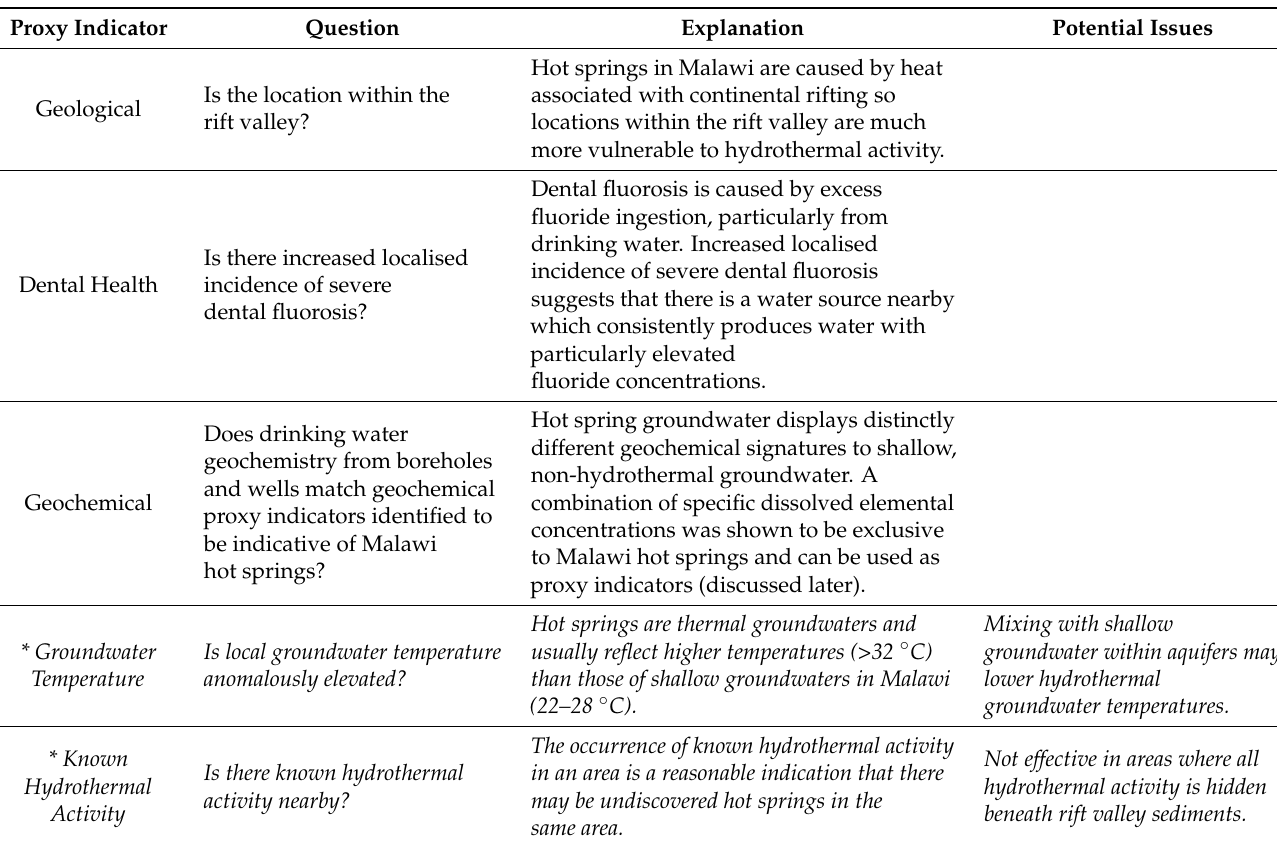
Table 1. Proxy indicators for hot spring activity considered within this study to locate and identify hidden hot springs in the southern part of Malawi’s unconsolidated rift basin